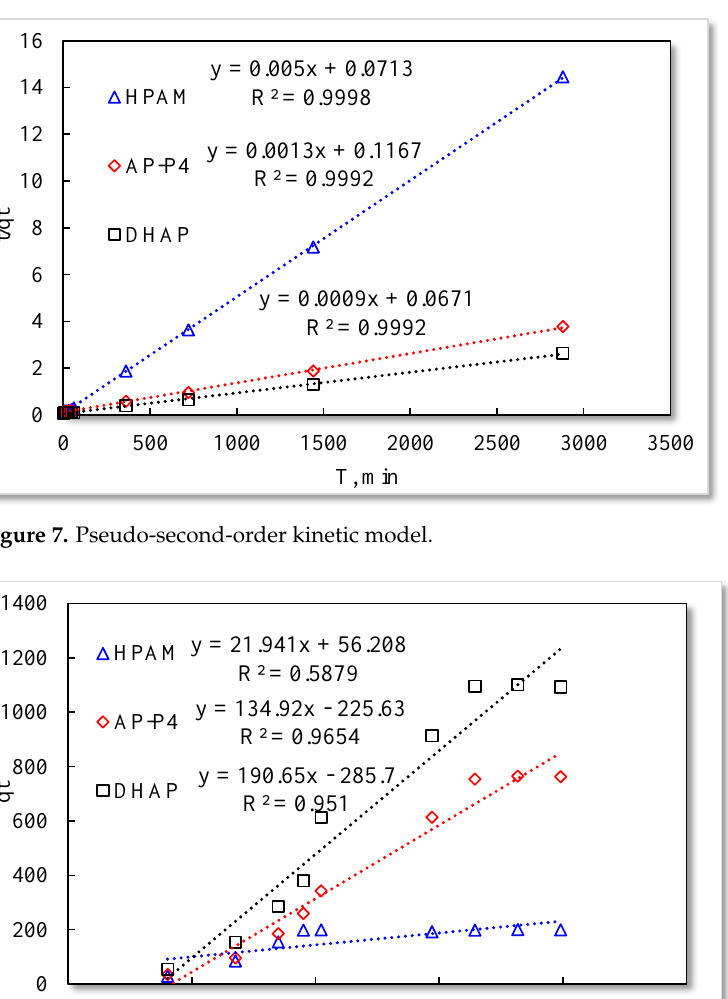
Figure 9. Pseudo − first − order kinetic model.